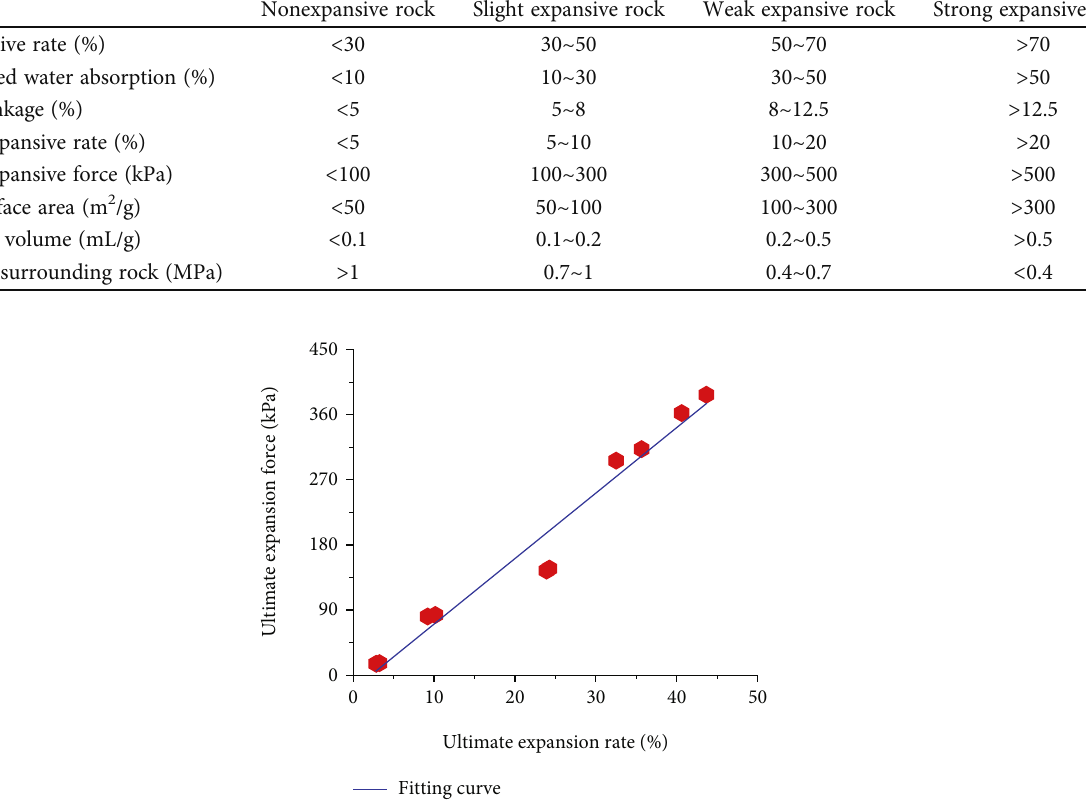
Figure 14: Relation curve between ultimate expansion rate and ultimate expansion force.